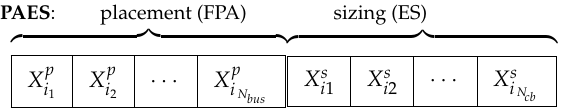
Figure 1. Placement and sizing strategies for FPAES